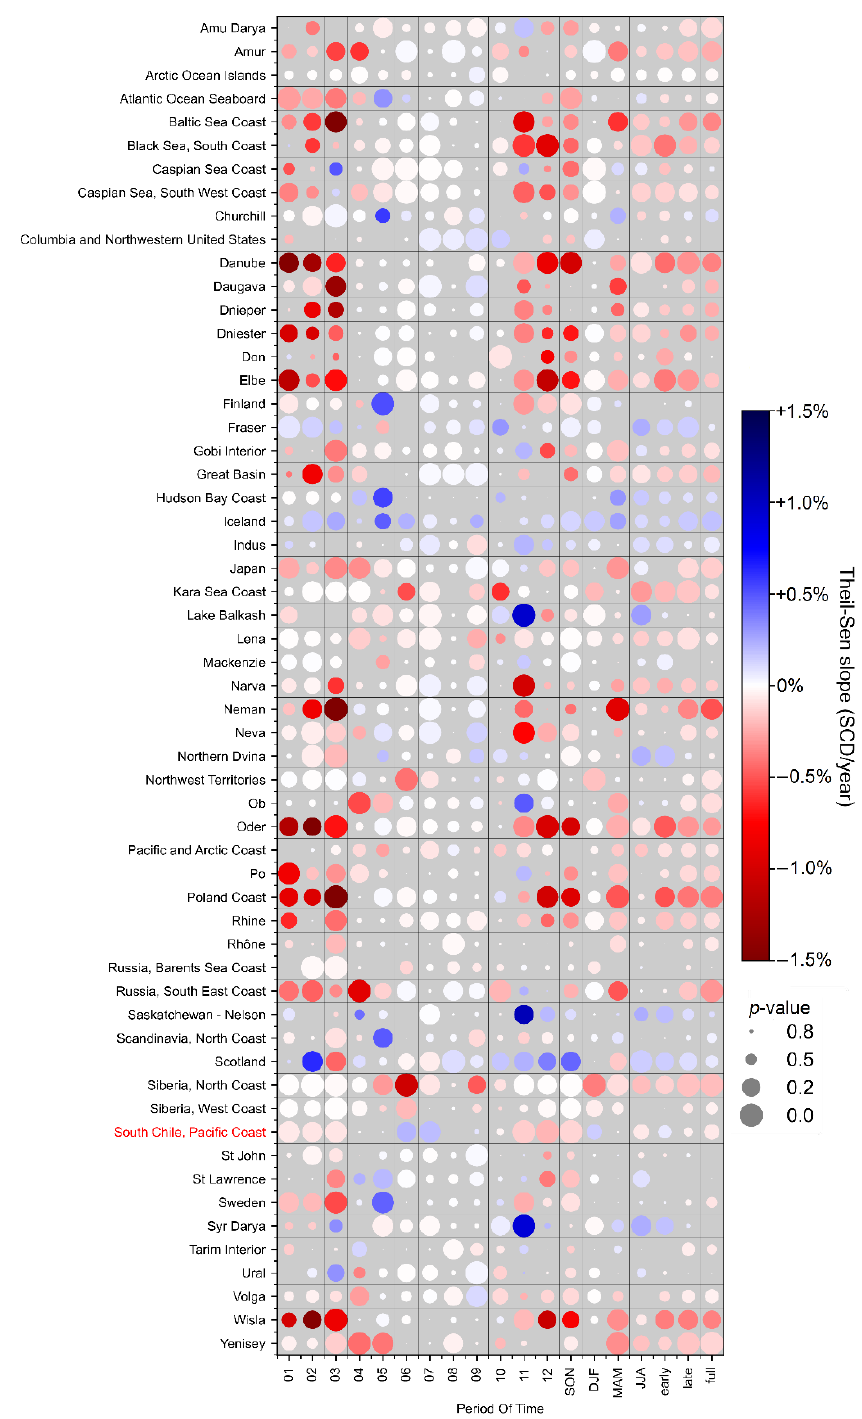
Figure 12. Summary of the trend analysis for the 57 studied major basin areas for the 19 periods of time. The color shows the magnitude of the SCD development (changes in duration percentage), the circle size indicates the significance (the larger, the closer the p -value is to 0). The only basin on the southern hemisphere is shown in red on the y-axis.